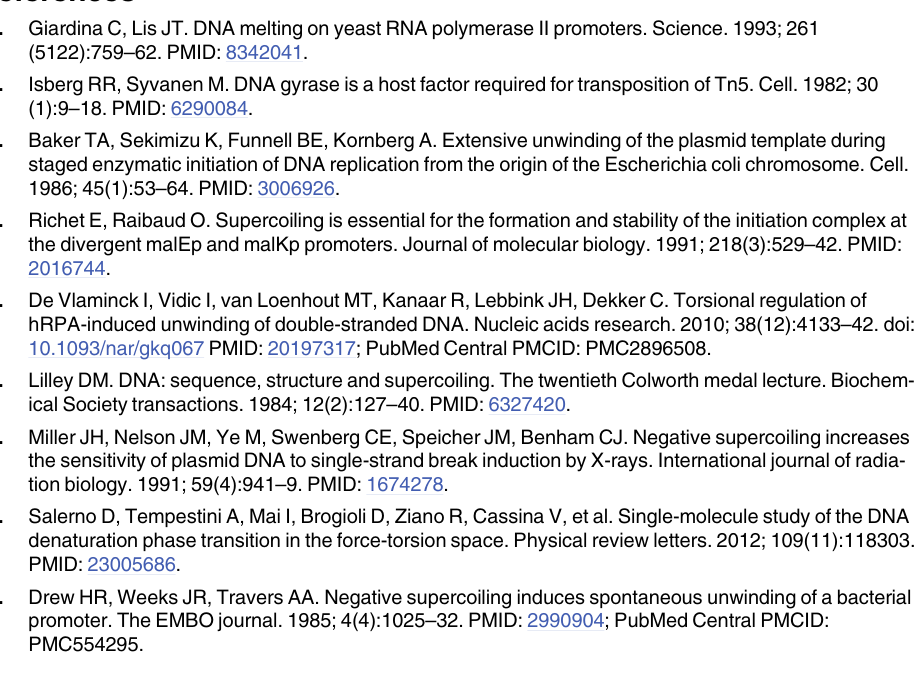
S1 Table. PCR and primer information of the Tweezer Constructs. Sequence of the primers used to PCR the 10kb DNA fragments which were used to clone into pCR-XL-Topo vector. All PCR ’ s were performed using KOD Xtreme polymerase (MerckMillipore). To be able to make the 77% GC construct we first developed two PCR ’ s ~5kb, which were cloned into pSuperCos1 (stratagene), using restriction enzymes specified (partially sequence verified). From this plas- mid the 10kb PCR was developed and cloned into pCR-XL-Topo